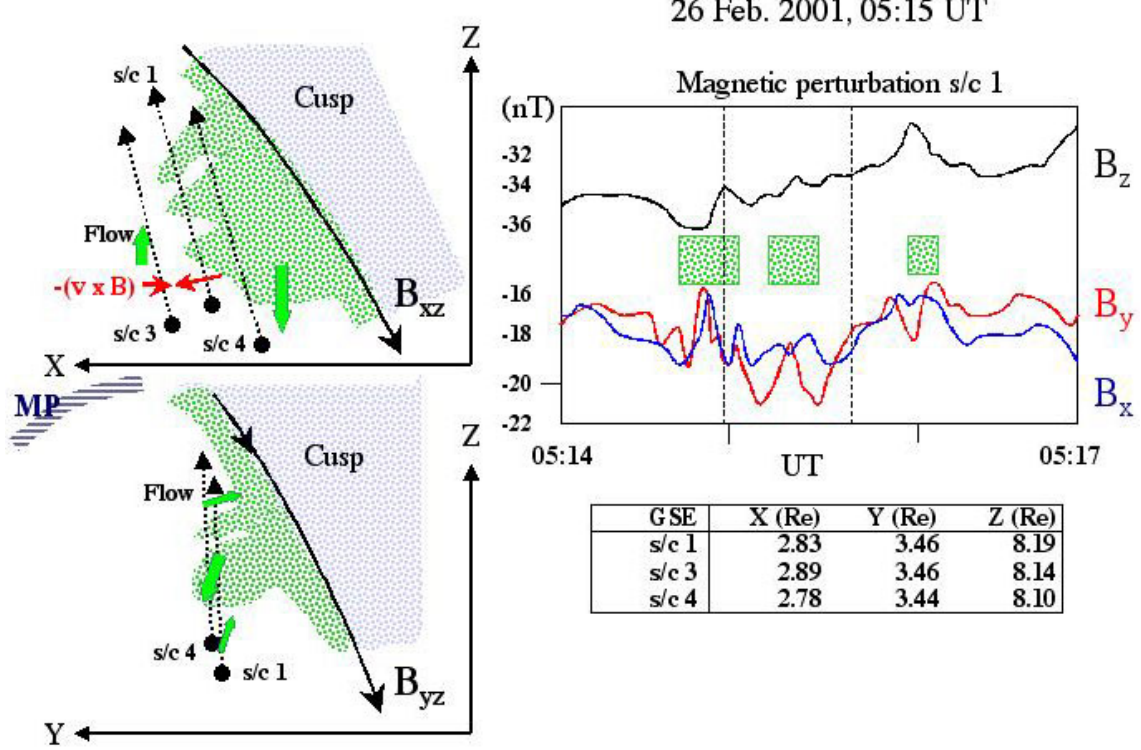
Fig. 6. Diagrammatic representation of several PTEs located immediately equatorward of the cusp as observed by Cluster s/c 1, 3 and 4 on 26 February 2001, 05:14–05:17UT.